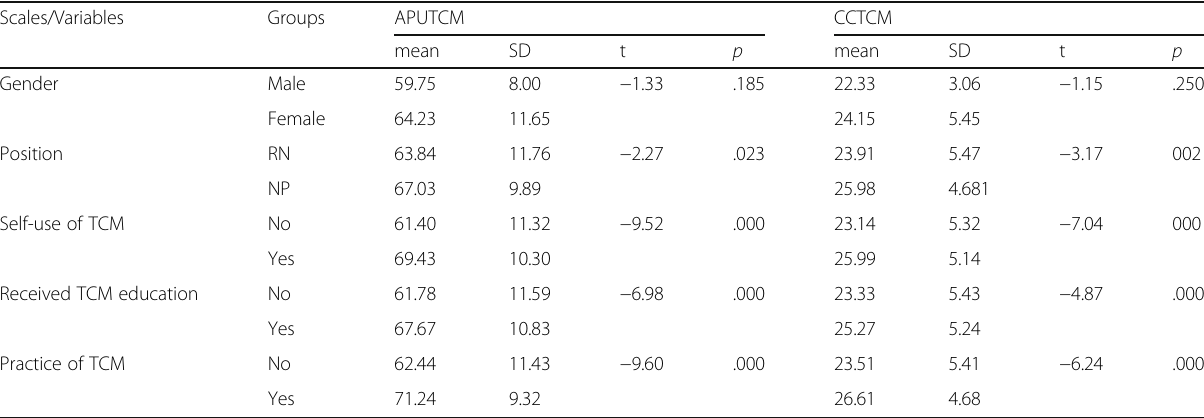
Table 3 Relationships between variables and scales Scales/Variables Groups